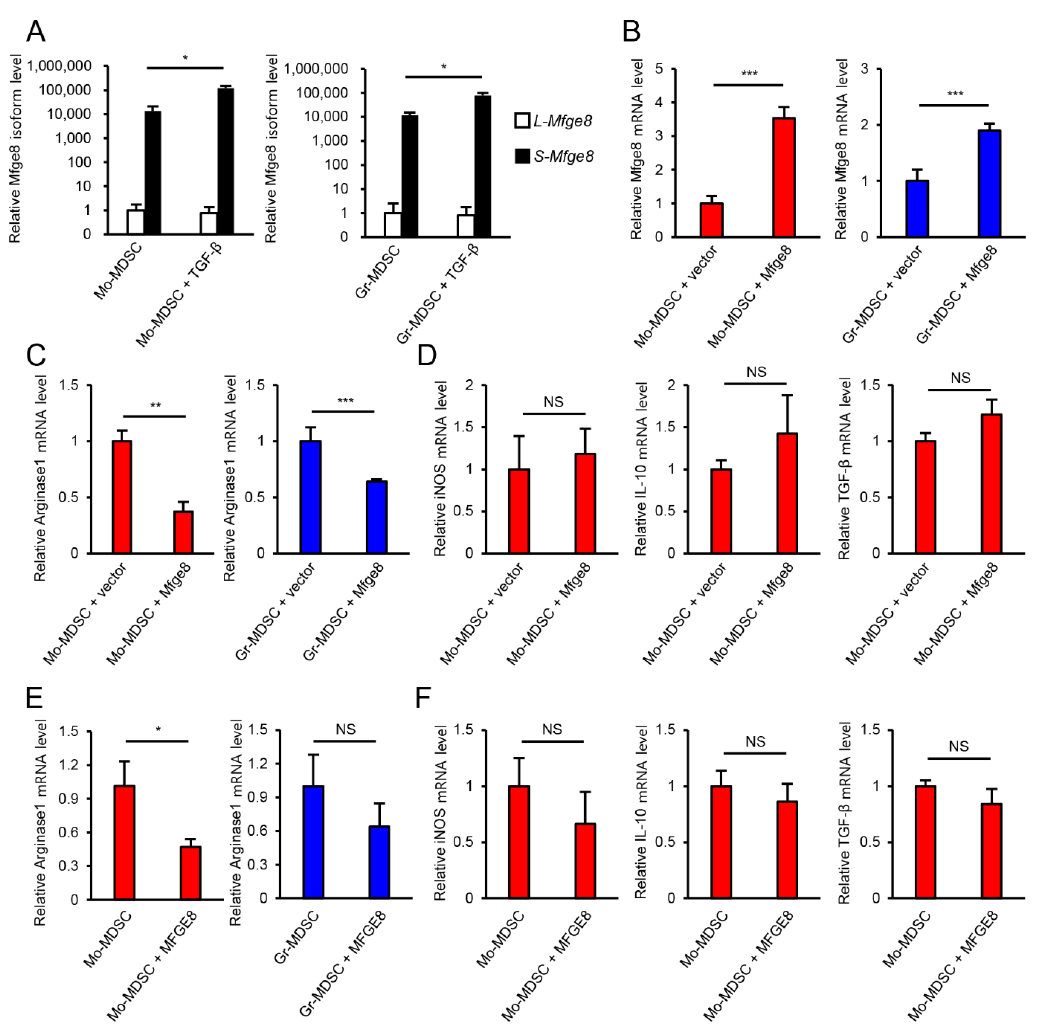
Figure 3. MFGE8 does not increase the immunosuppressive function of MDSCs. ( A ) Analysis of L-MFGE8 and S-MFGE8 mRNA levels in Mo-MDSCs and Gr-MDSCs by qPCR. ( B ) MFGE8 overexpression was confirmed by qPCR after sorting of transduced cells. ( C ) The arginase1 mRNA level in MFGE8-overexpressing Mo-MDSCs and Gr-MDSCs. ( D ) mRNA levels of MDSC effector molecules in MFGE8-overexpressing Mo-MDSCs under LPS stimulation condition. ( E ) The arginase1 mRNA level in MFGE8-treated Mo-MDSCs and Gr-MDSCs. ( F ) mRNA levels of MDSC effector molecules in MFGE8-treated Mo-MDSCs under LPS stimulation condition. Data are expressed as the mean ± SD. NS, not statistically significant ( p > 0.05). * p < 0.05, ** p < 0.01, and *** p < 0.001 by two-tailed t -test.